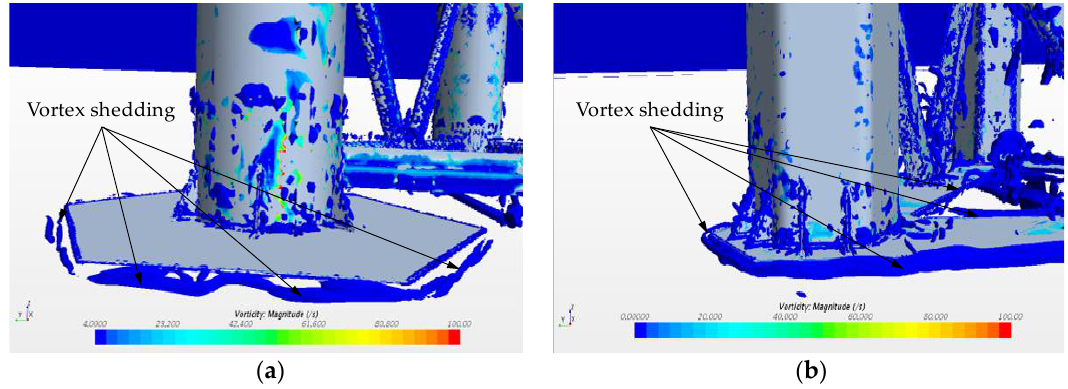
Figure 6. The vorticity of ( a ) WindFloat-type platform and ( b ) HexaSemi.